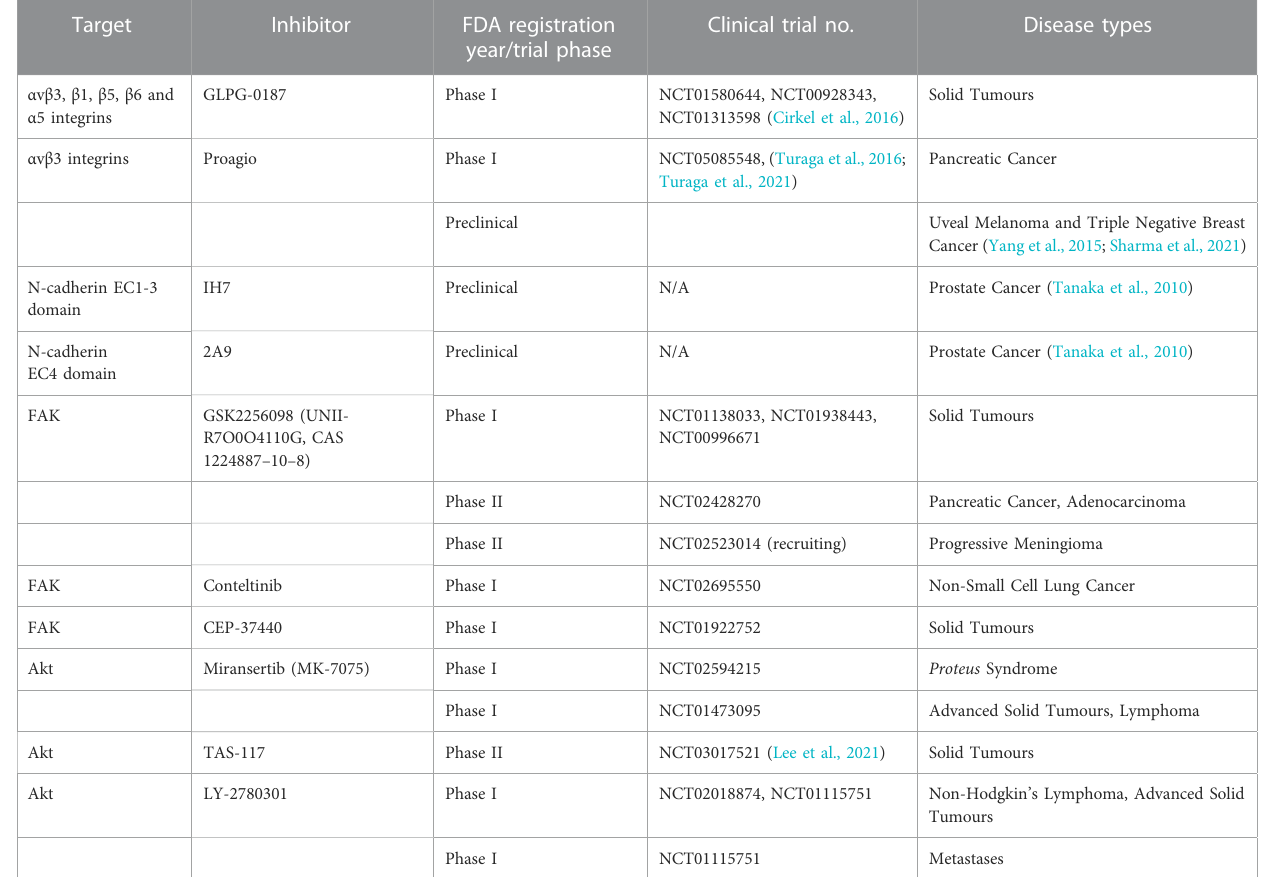
TABLE 2 Pharmacological Inhibitors yet to be examined in